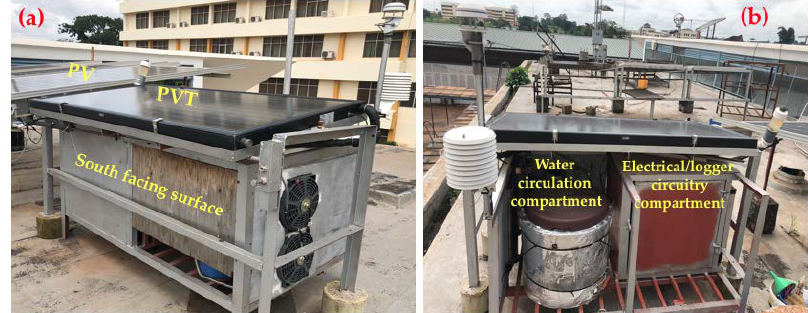
Figure 2. Photovoltaic-thermal (PVT) showing: ( a ) south facing surface and cooling fans for radiator (left); ( b ) north facing face with water circulation compartment and electrical/logging circuitry compartment (right).